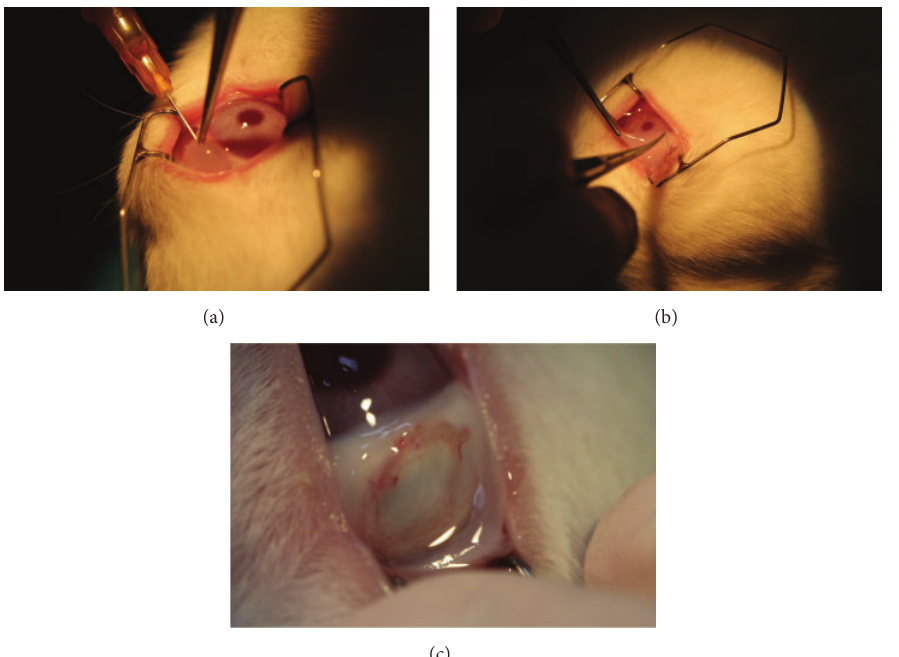
Figure 1: (a) Injection of BSS (cid:2) into the subconjunctival space for dissection. (b) The excision of conjunctiva and Tenon’s capsule with Westcott scissors. (c) A 5 × 5 mm square shaped tissue defect in the rabbit